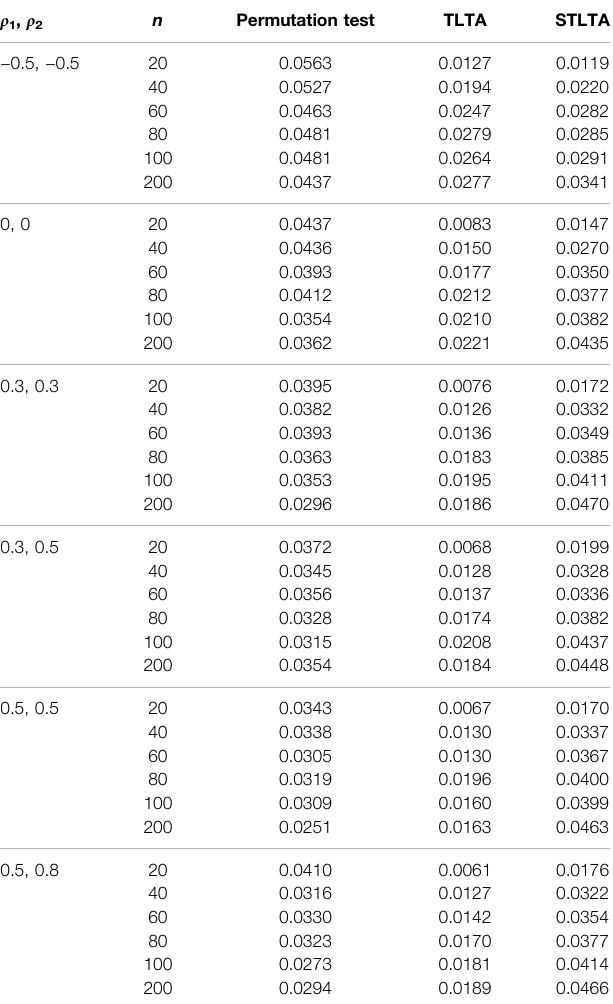
TABLE 4 | Type I error rate for different methods (the third to fi fth columns) in the AR(1) model when t = 0.5. The fi rst and second columns represent different combinations of autoregressive coef fi cients and sample sizes. The number of permutation tests is 1,000, the number ofrepeated simulations is 10,000, and the signi fi cance level is α =